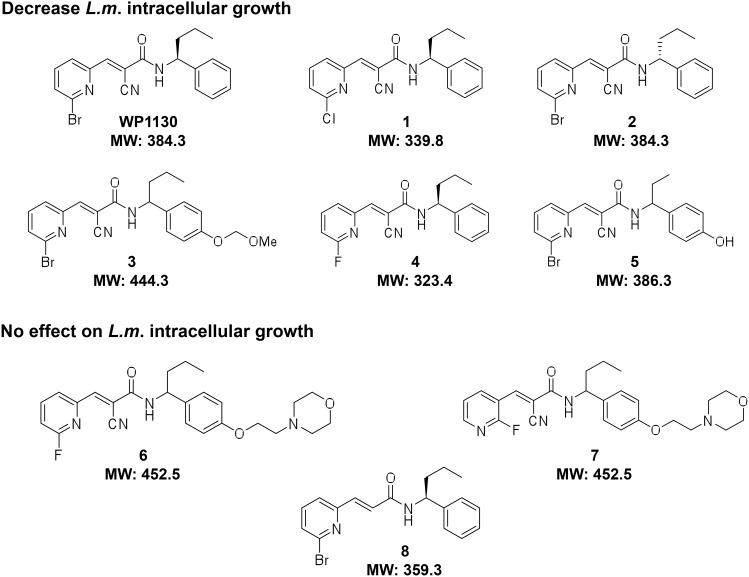
Structures and molecular weights of WP1130-derivative compounds.